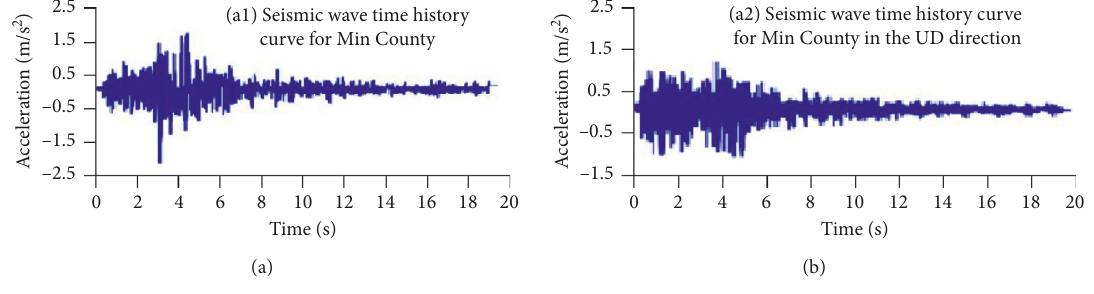
Figure 7: Seismic wave of Min